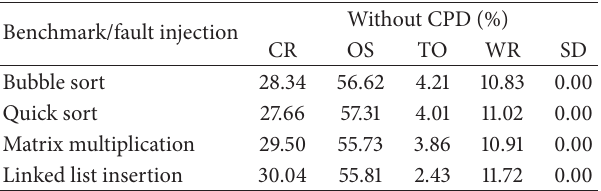
Table 5: Fault injection results on kernel components without CPD on core component.